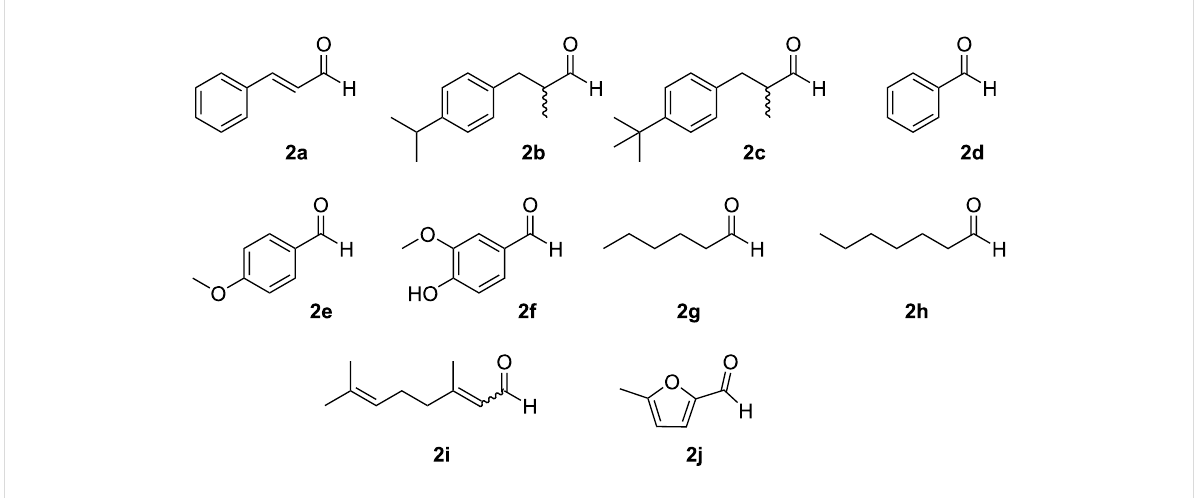
The aldehyde selected for the optimization of reaction condi- tions was cinnamaldehyde ( 2a ), as it is strongly UV absorbing, i.e., easy to follow by TLC. But in the end, the reaction progress was monitored by MS due to the fast hydrolysis of the imine even during the chromatography on TLC plates. Methanol was chosen as a solvent because it dissolves the aldehydes well and sufficiently ( ≈ 5 mg/mL) amine 1